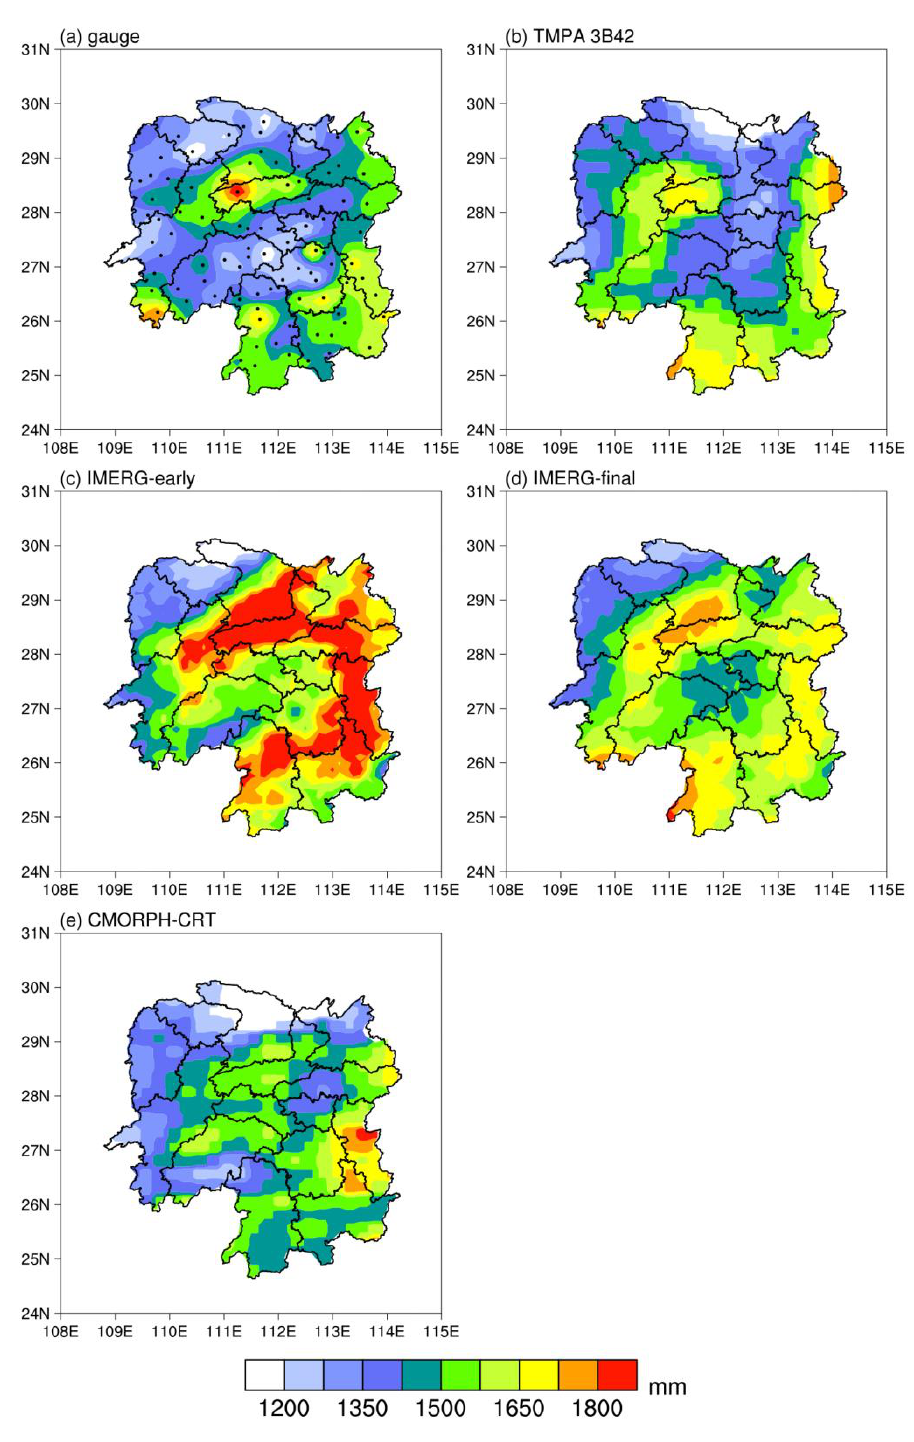
Figure 1. Annual mean precipitation for 2017 – 2019.